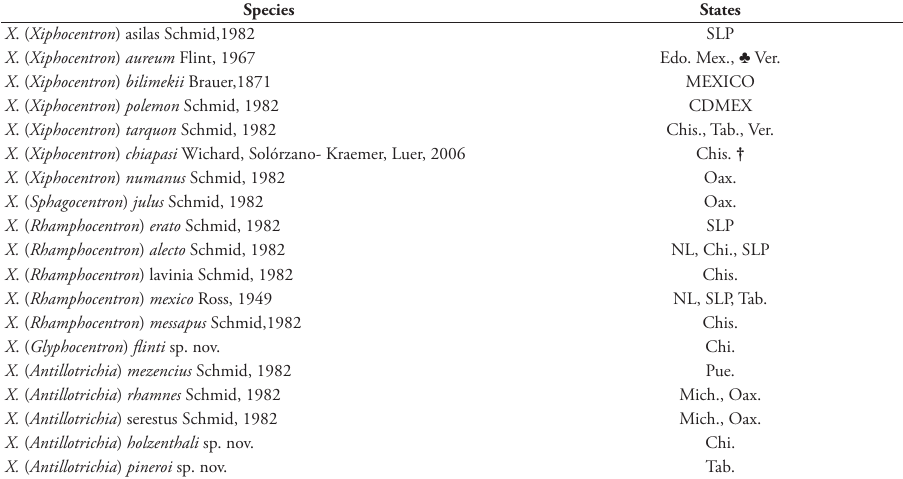
Table 1. Distribution of the genus Xiphocentron Brauer, 1870 in Mexico. Chihuahua (Chi.), Nuevo León (NL), San Luis Potosí (SLP), Michoacán (Mich.), Estado de México (Edo. Mex.), Ciudad de México (CDMEX), Puebla (Pue.), Veracruz (Ver.), Oaxaca (Oax.), Tabasco (Tab.), Chiapas (Chis.), ( † fossil), ( ♣ New